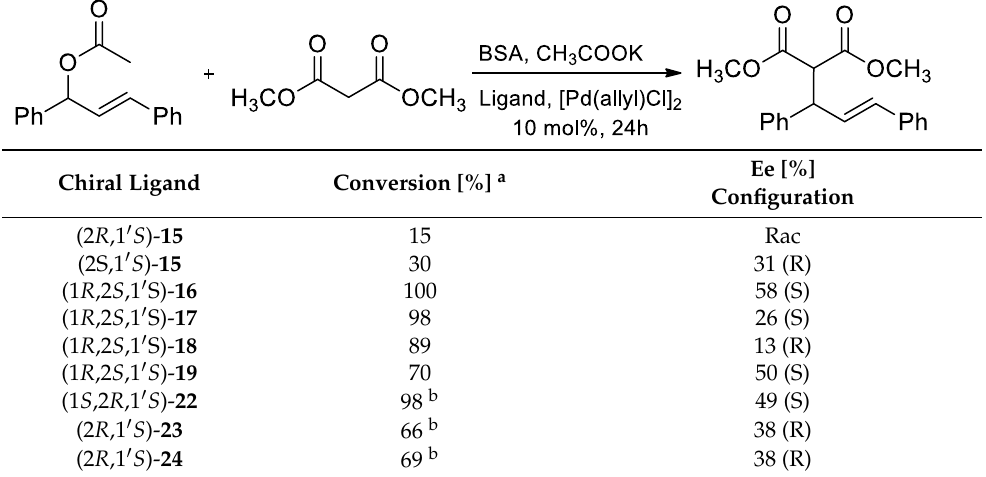
Table 3. Catalytic Tsuji-Trost reaction.